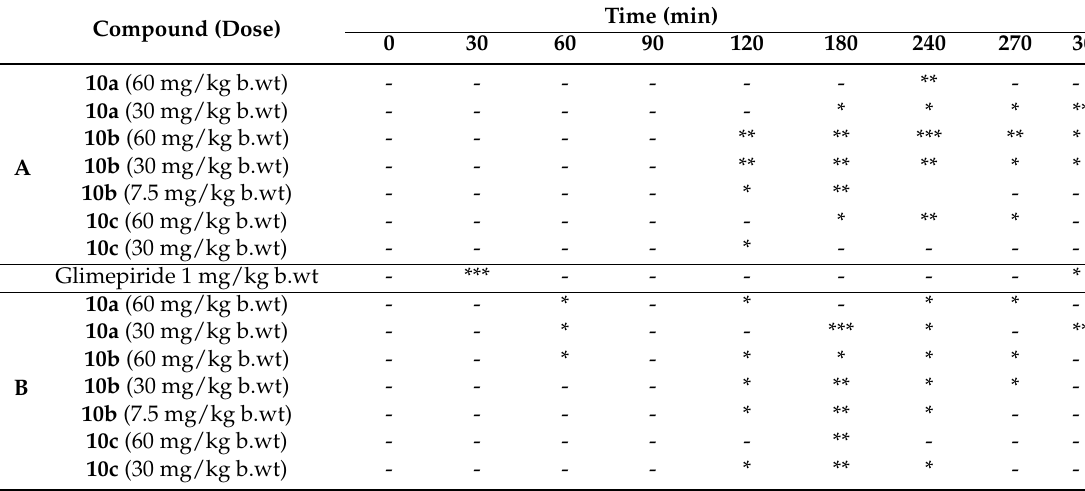
Table 1. P -value for SPSS results in normal mice. Compound